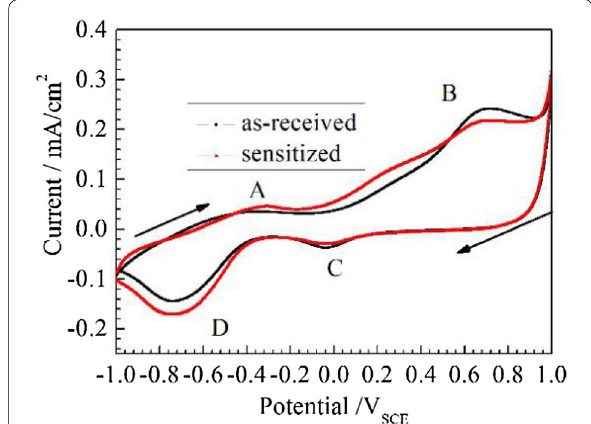
Figure 3 Cyclic voltammograms results for as-received and sensitized AISI304 stainless steel with scan rate of 50 mV/s in borate buffer solution